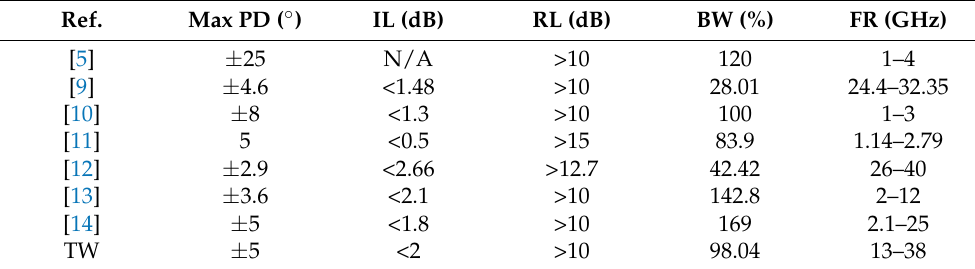
Table 2. Performance comparison between reported 180 ◦ phase inverters.